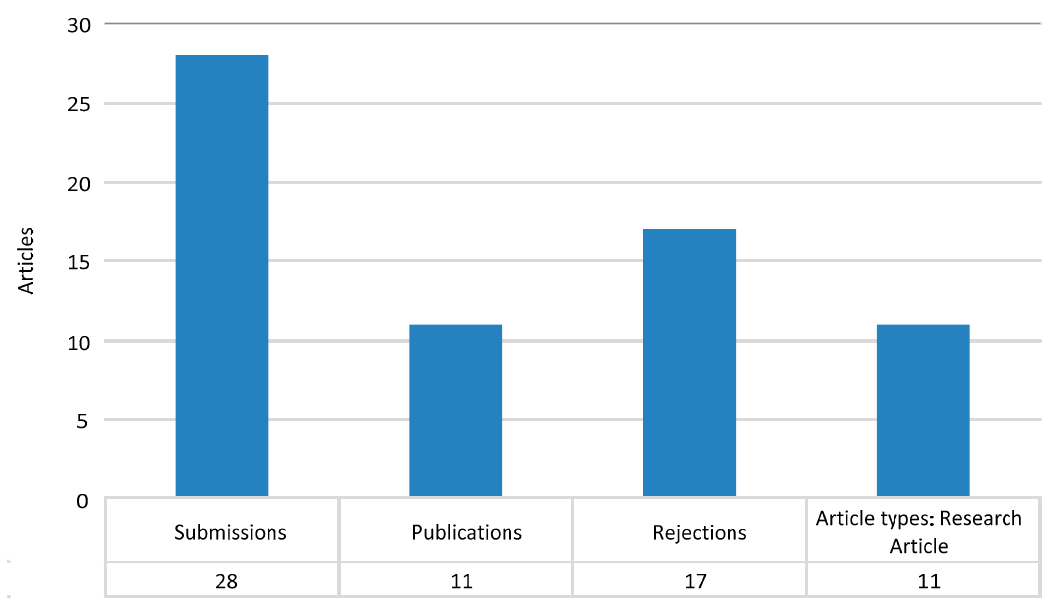
Figure 1. Special Issue statistics.